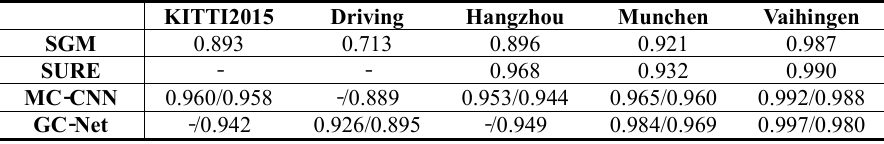
Table 3. The results of SGM and SURE on the aerial datasets (parallax error < 3 pixels).